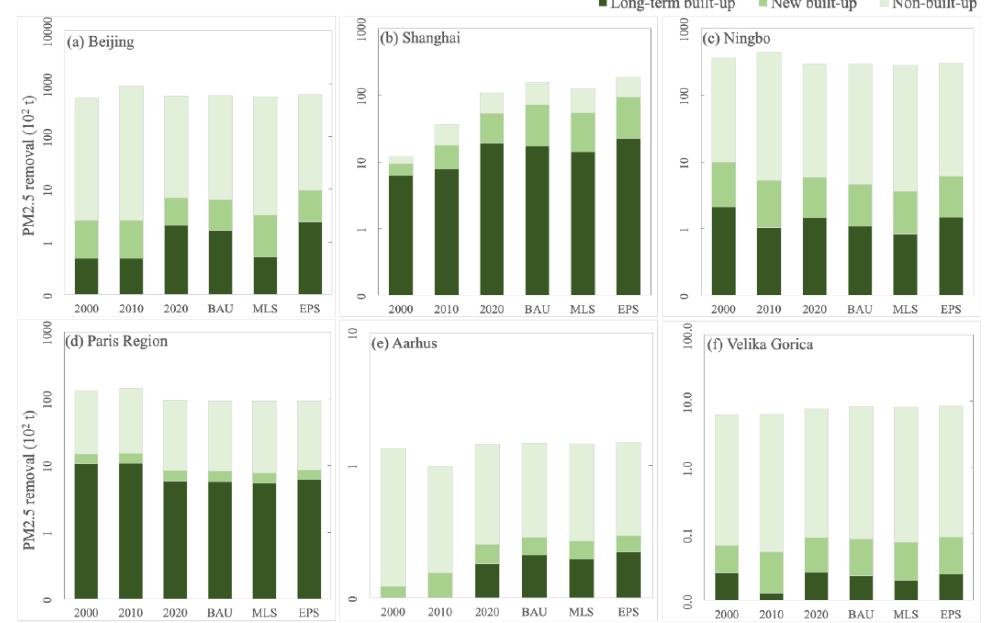
Figure A6. Changes in PM2.5 removal changes for 2000 to 2020 and 2020 to 2030 in Paris region, Aarhus, and Velika Gorica under three different scenarios (BAU, MLS, and EPS). Similar to carbon storage, PM2.5 removal is also greatly affected by land cover changes.